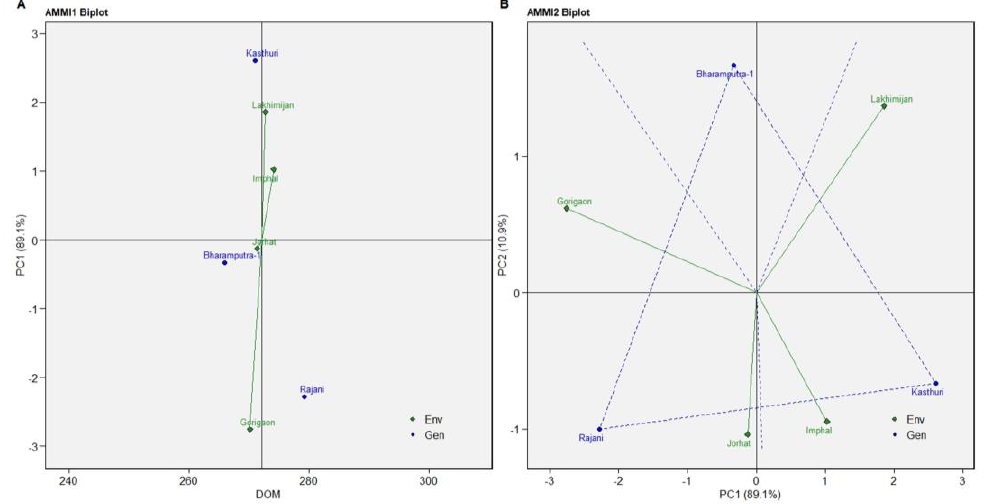
Figure 7. ( A ) AMMI1 biplot ( B ) AMMI2 biplot for days to maturity. The GC/MS analysis of the essential oil extracted from Bharamputra-1 is